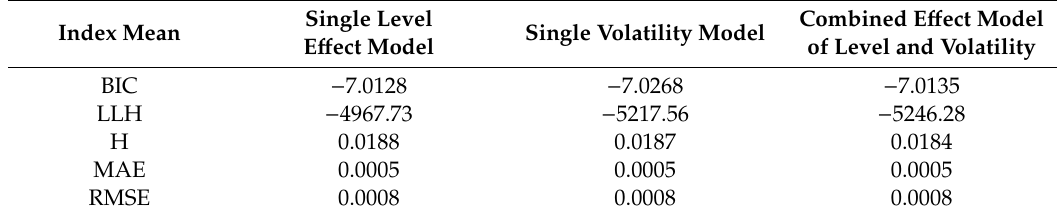
Table 8. Comparison of average estimation results between associative e ff ect model and the single-factor level and fluctuation e ff ect model in the low-frequency